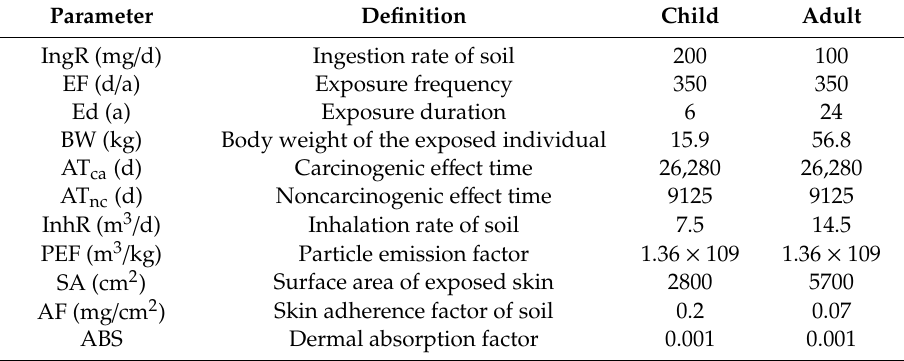
Table 4. Exposure parameters of the health risk assessment